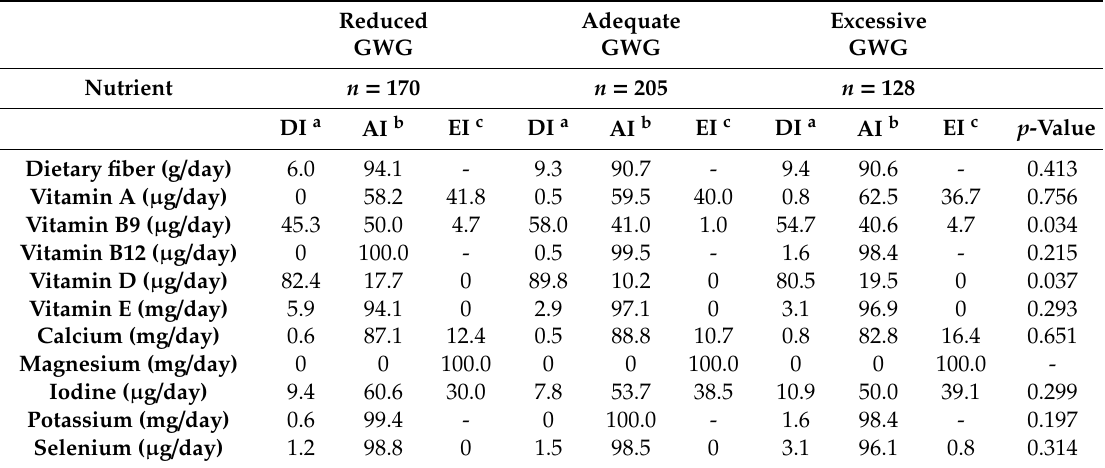
Table 5. Prevalence of participants with an adequate, deficient, or excessive intake of nutrients according to 2 / 3 EFSA DRIs stratified by